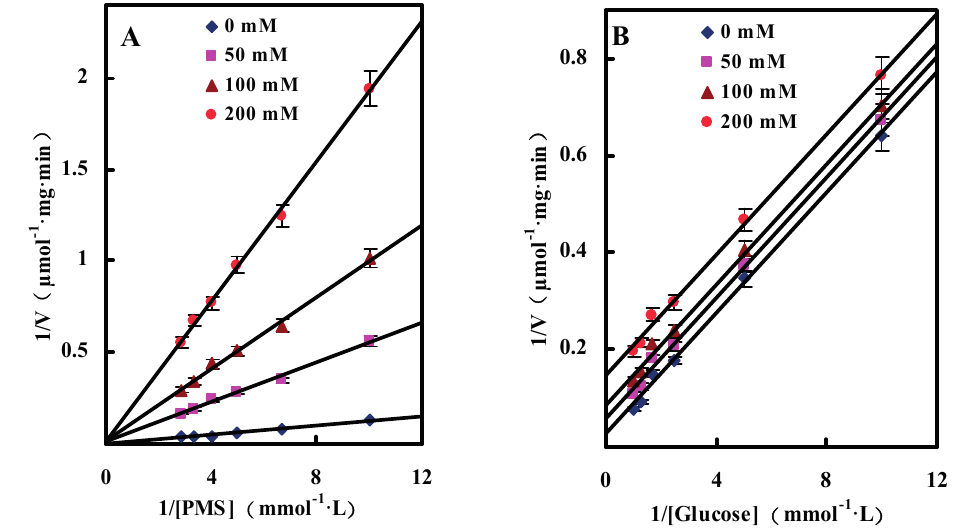
Figure 5. The kinetics of inhibition of the GlcDH reaction by gluconic acid. ( A ) 1/v versus 1/[PMS] at 33 mM glucose and the following fixed concentration of gluconic acid: 0 mM, 50 mM, 100 mM and 200 mM; ( B ) 1/v versus 1/[glucose] at 100 µM PMS and the following fixed concentration of gluconic acid: 0 mM, 50 mM, 100 mM and 200